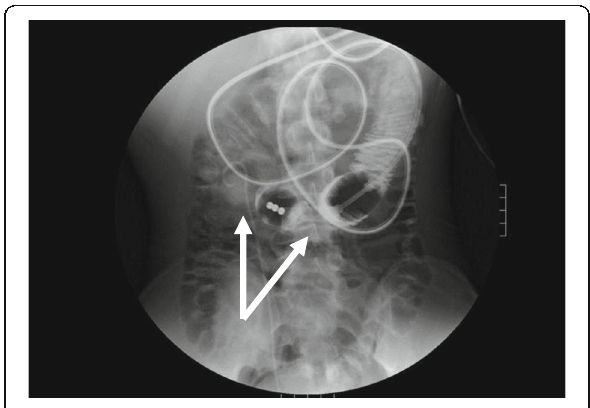
Fig. 2 Gastrointestinal contrast study showing at least two stenotic areas in the small bowel (white